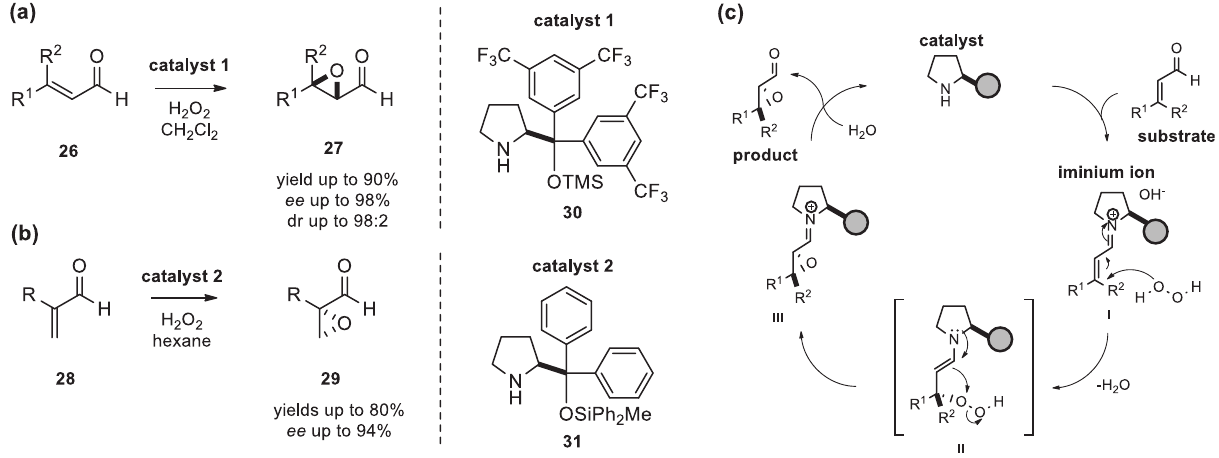
Figure 8 . Two examples of catalytic enantioselective epoxidation of enals: (a) from Ref. [32]; (b) from Ref. [33] and (c) hypothesised